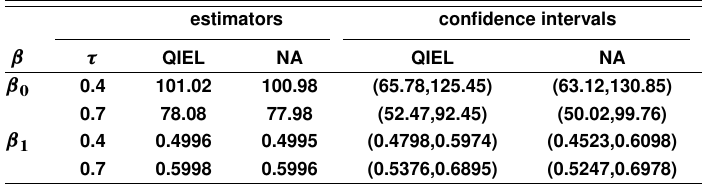
Table 6. The estimators and confidence intervals of ˇ based on QIEL and NA in Engel data